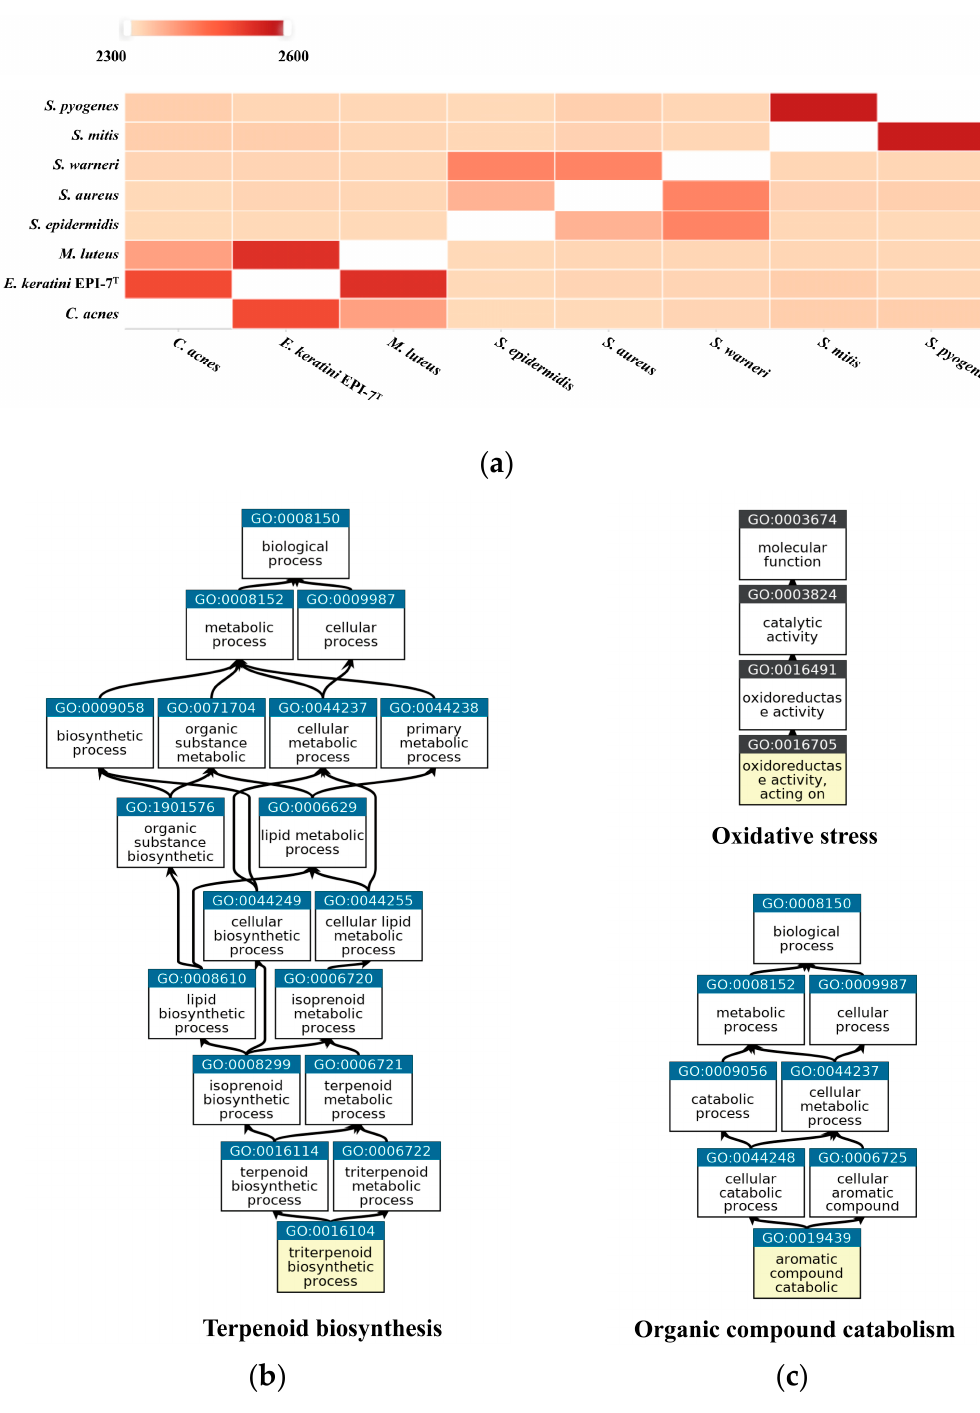
Figure 6. Pairwise heatmap based on amino acid sequence and GO enrichment. ( a ) In the pairwise heatmap, each cell is the overlapping cluster number between the two genomes in contact with the horizontal and vertical axes, and the darker the color, the higher the overlapping cluster number. Pairwise heatmap based on amino acid sequence confirmed that C. acnes and M. luteus showed the highest association with E. keratini EPI-7 T . ( b ) GO enrichment based on GO terms showed that C. acnes , M. luteus , and E. keratini EPI-7 T shared “Terpenoid biosynthetic process”, but ( c ) “Aromatic compound catabolic process” and “Oxidoreductase activity” was unique to E. keratini EPI-7 T .